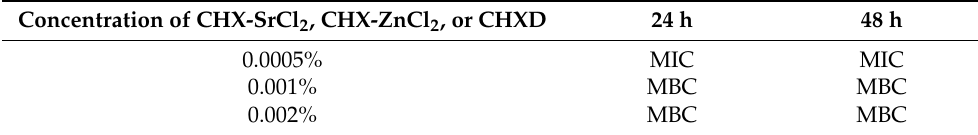
Table 2. MIC and MBC of CHX-ZnCl 2 , CHX-SrCl 2 , and CHXD against F. nucleatum subsp. polymor- phum (strain—ATCC10953) .